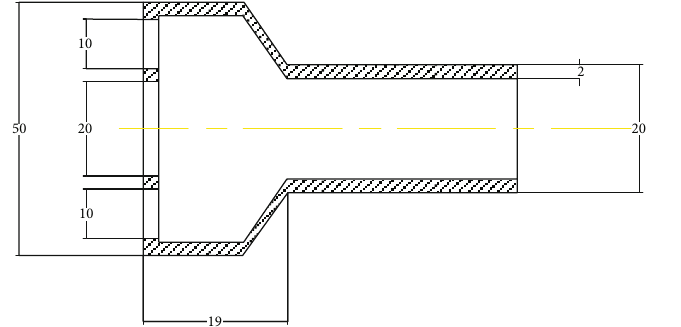
Figure 6: Mixing chamber geometry.